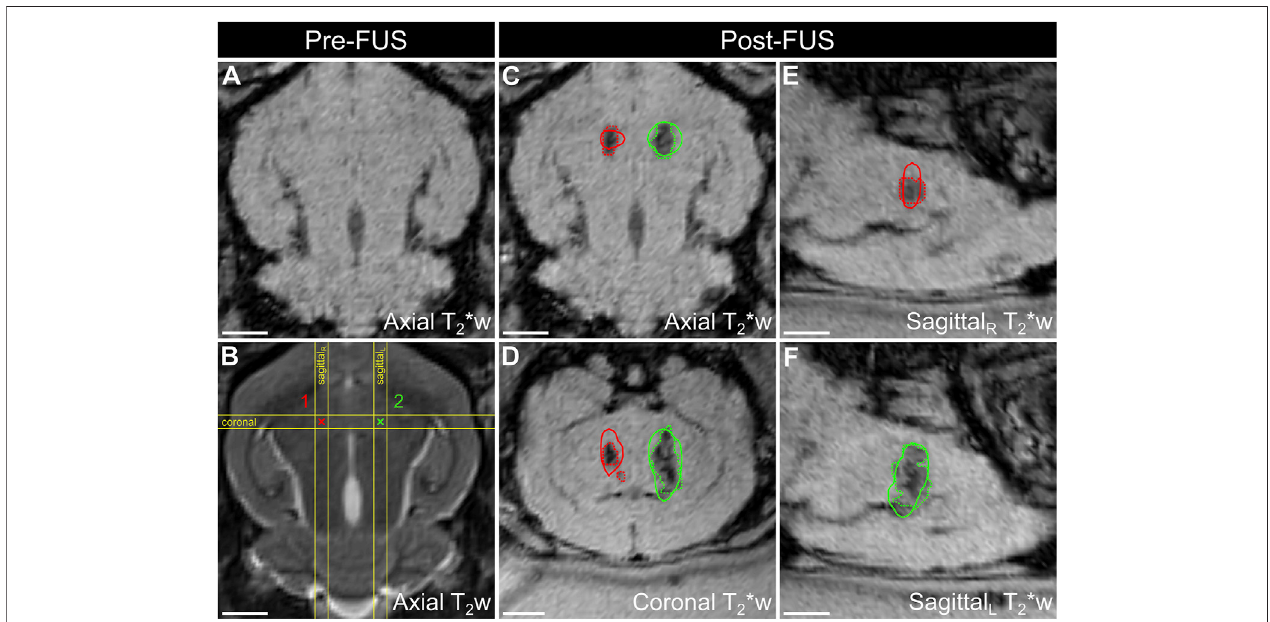
FIGURE 5 | Spatial correlation of ultrafast 3D microbubble cavitation with focused ultrasound (FUS) brain tissue damage in a rabbit model. Baseline T 2 p w (A) and T 2 w MRI (B) images pre-sonicationdepicttarget locationsfortwofocusedultrasoundtreatmentconditions(labeled1and2). Axial, coronalandsagittal T 2 p w MRIimages immediately post-sonication [ (panels C – F) respectively] depict hypointense regions indicative of tissue damage (dotted lines) overlaid by the corresponding spatial microbubblecavitationdata(solidlines).ThecoronalandsagittalslicevolumesareindicatedinpanelB(yellowlines).Scalebar=5 mm.Figuremodi fi edfromJones et al Theranostics , 2020 [183] with permission from the authors.